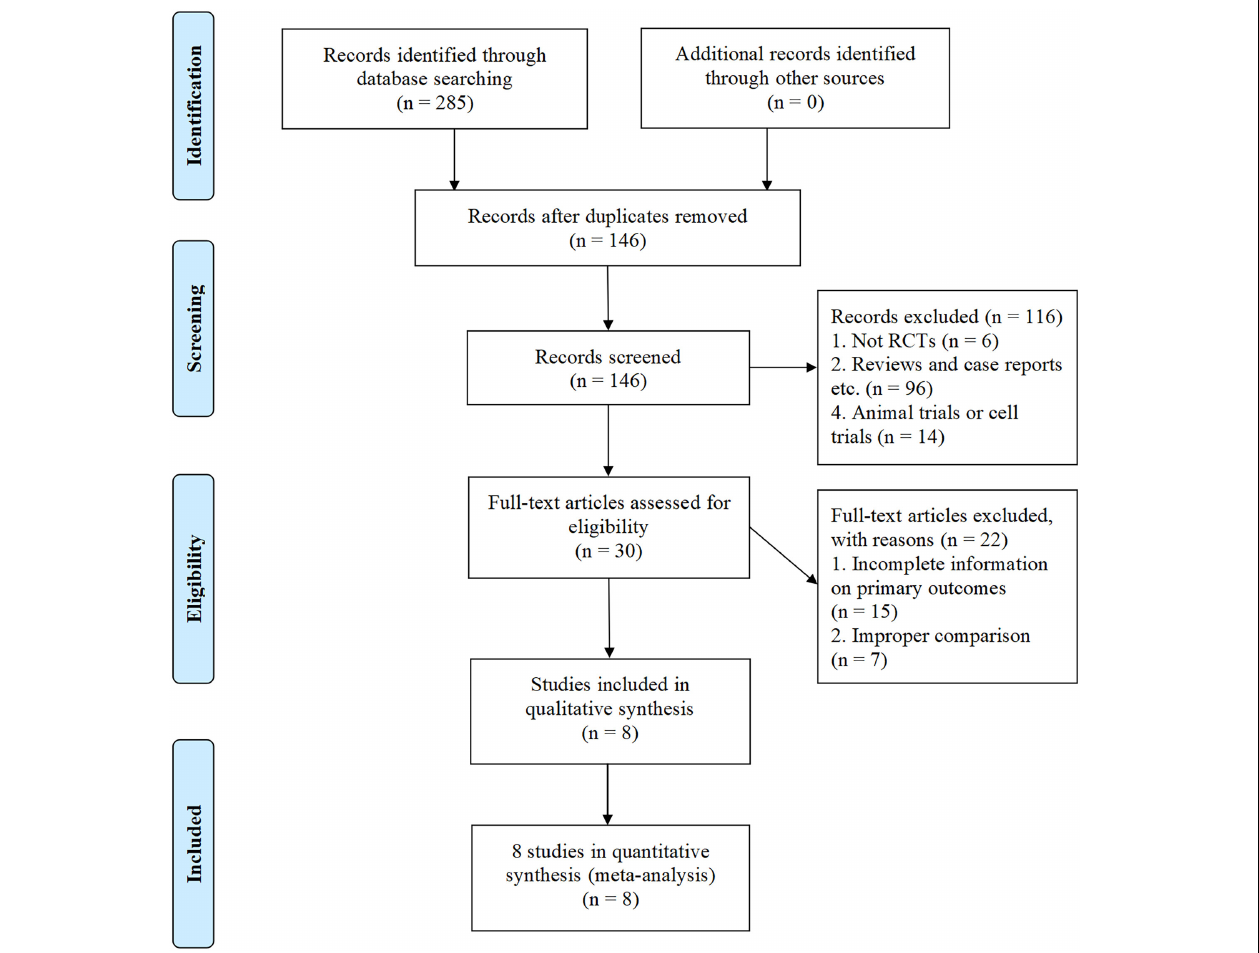
FIGURE 1 | PRISMA flow diagram of study selection